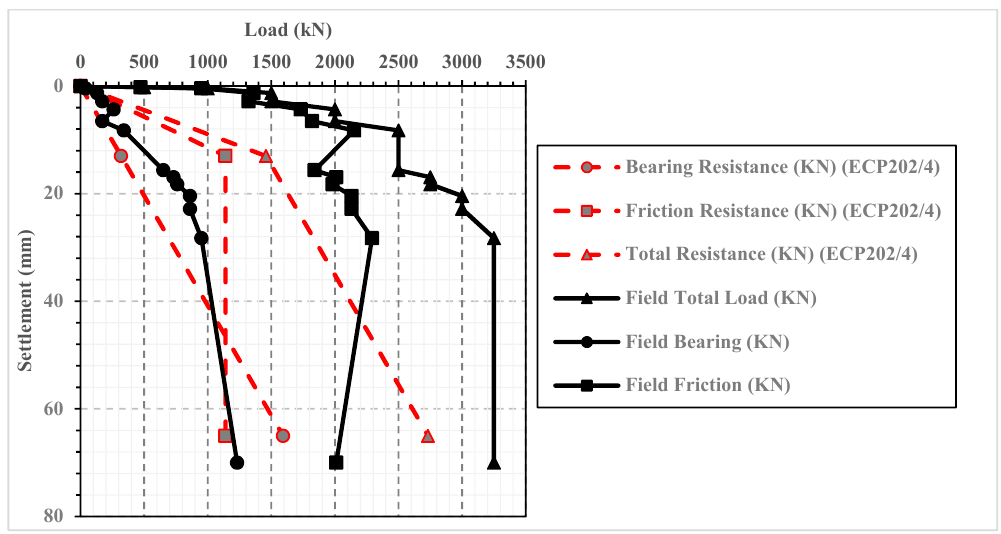
Figure 15. Comparison between field measurements of Alzey case history, and calculated values of pile settlement, friction, bearing, and total ultimate load using a settlement-based method [23].